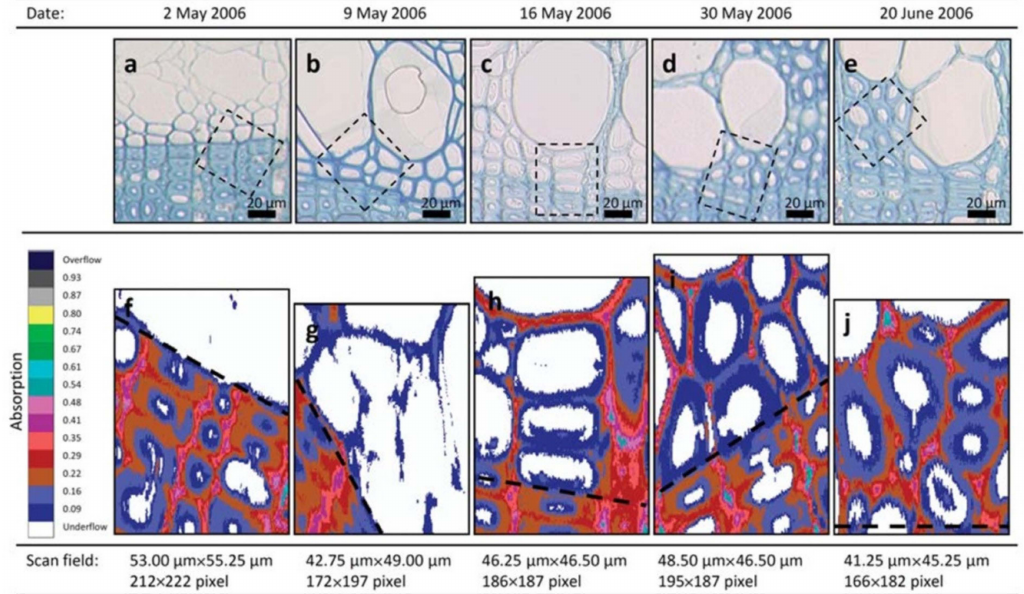
Figure 9. Progressive differentiation and lignification of newly formed xylem tissue in the tree from 2 May to 20 June 2006. ( a – e ) Light microscopic pictures of the first formed tissue near the growth ring boundary stained with toluidine blue showing different stages of cell wall development; the frames indicate the area of scanning fields. ( f – j ) Images of ultraviolet microscope analysis showing the absorbance values at different stages of cell wall lignification; black dashed lines indicate the growth ring boundaries. The progressive lignification can be followed from ( f ) no absorbance detected on the 2 May to ( j ) maximal absorbance of completely formed fibers on the 20 June